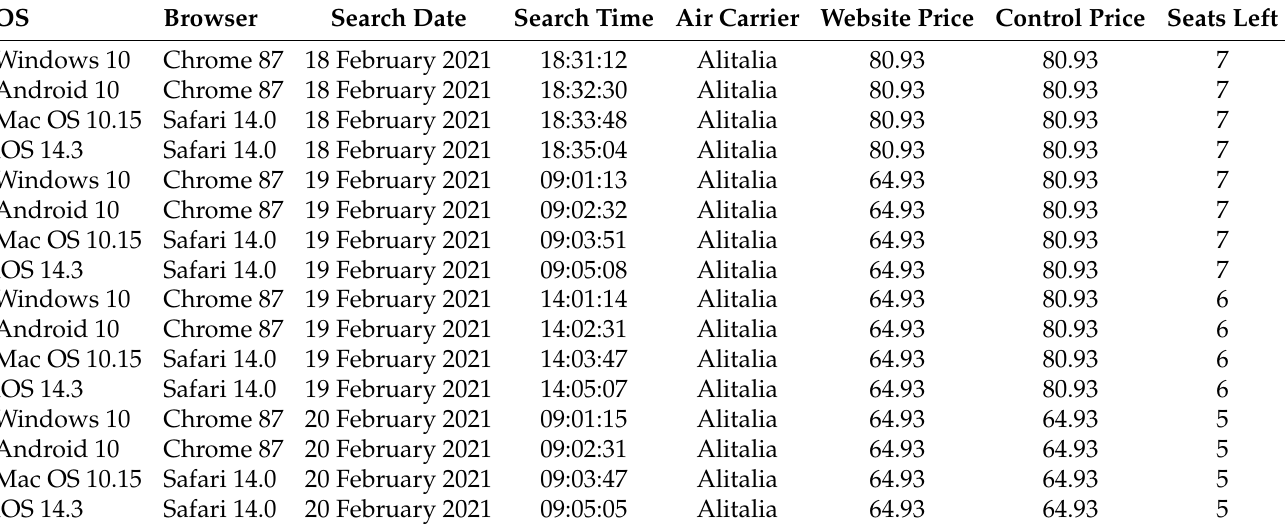
Table 4. Price difference detected: website price lower than